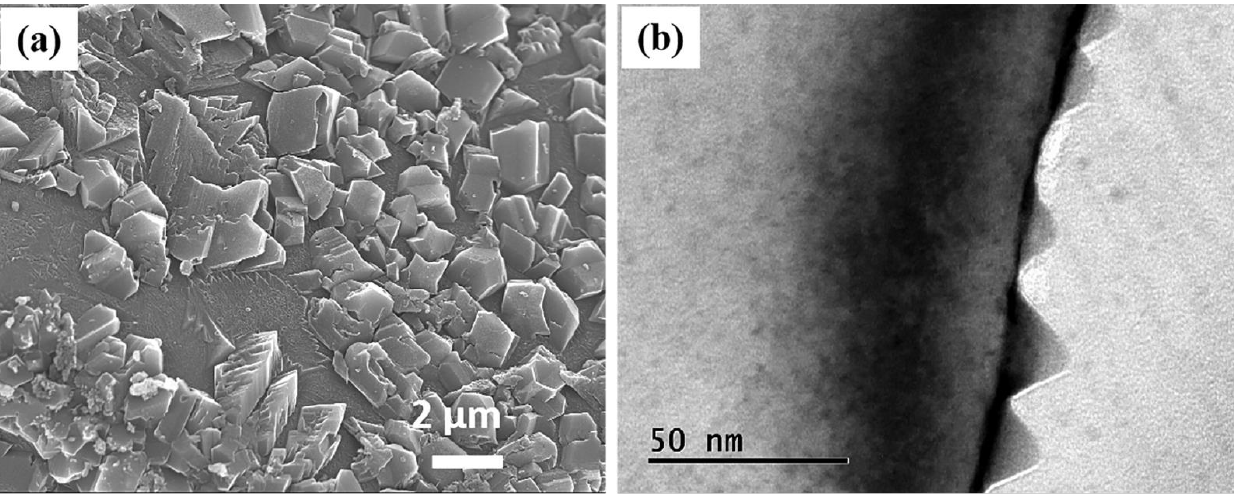
Figure 3. ( a ) B 4 C microstructure at Diamond-Cu interface; and ( b ) microstructure at diamond-B 4 C interface.